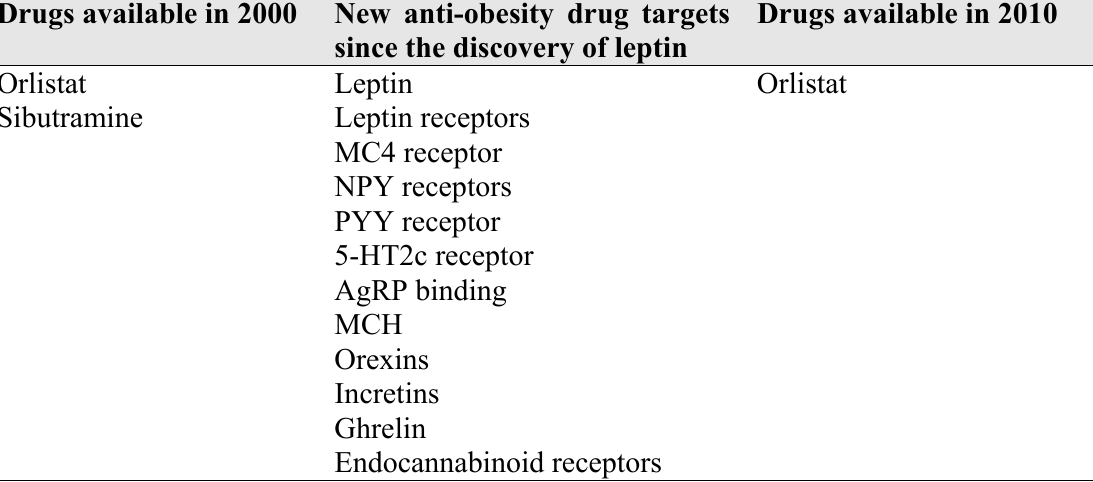
Table 1. Anti-obesity